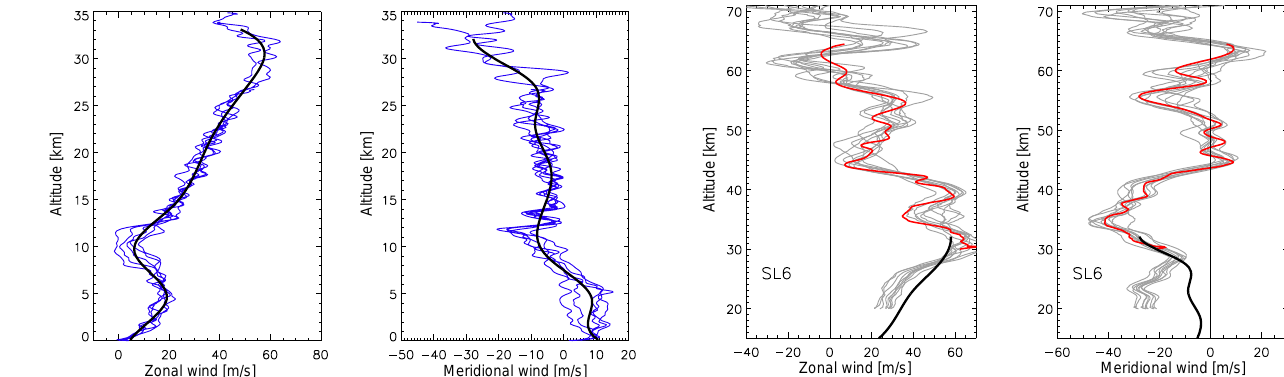
Figure 7. Radiosonde flights on 14/15 March 2015 relevant for the comparison with DoRIS. Blue: individual profiles, black: mean and smoothed profile. Left: zonal winds, right: meridional winds.